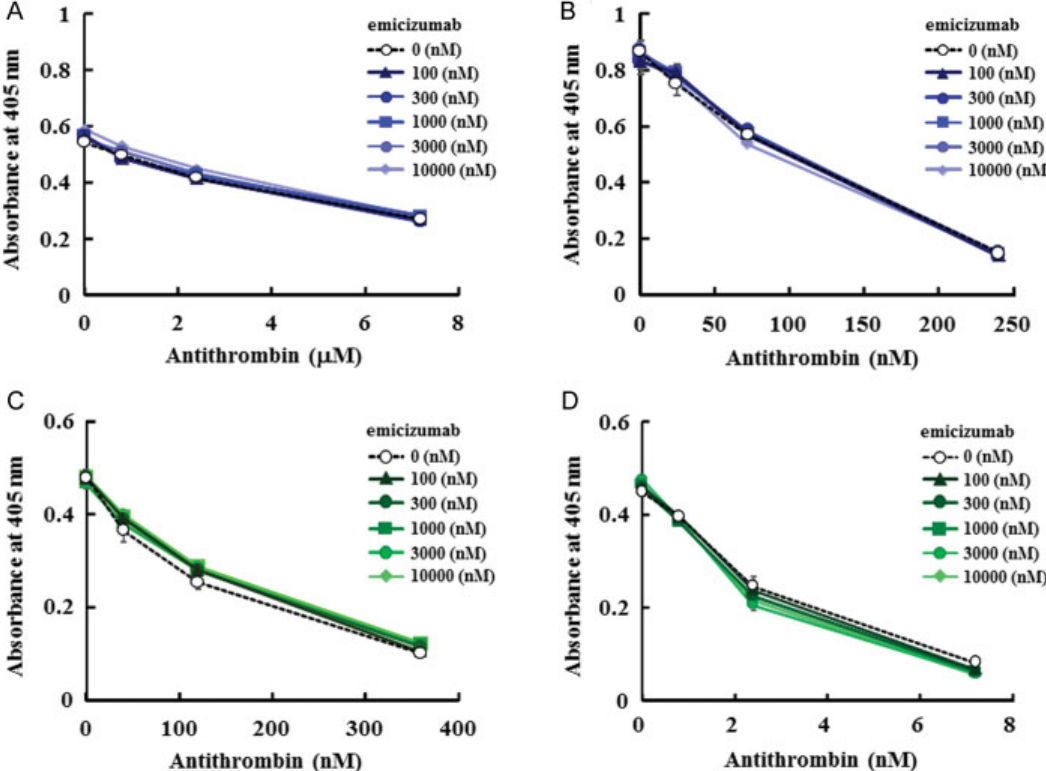
Fig. 1 EffectofemicizumabontheactionofATonFIXaandFXainenzymaticassays.( A )Emicizumab ’ seffectontheactionofATonFIXa.( B )Emicizumab ’ s effectontheactionofATonFIXainthepresenceofheparin.( C )Emicizumab ’ seffectontheactionofATonFXa.( D )Emicizumab ’ seffectontheactionofATon FXainthepresenceofheparin.Dataareexpressedasmean (cid:2) SD( n ¼ 3).ThebarsdepictingSDareshorterthantheheightofthesymbols.Thesymbolsfor the groups with higher concentrations of emicizumab are hidden behind the symbols for the other groups.